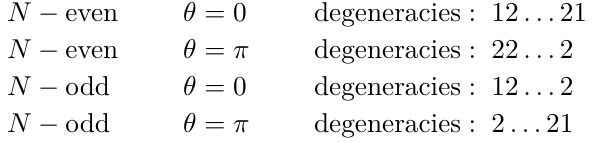
Figure 5 . ∆ E k is the spectral gaps in reduced QM. m 2 Polyakov model on R 3 (red points) and deformed YM on R 3 × S 1 (black points). Both have a spectral band width of order ξ ∼ e − S 0 . See